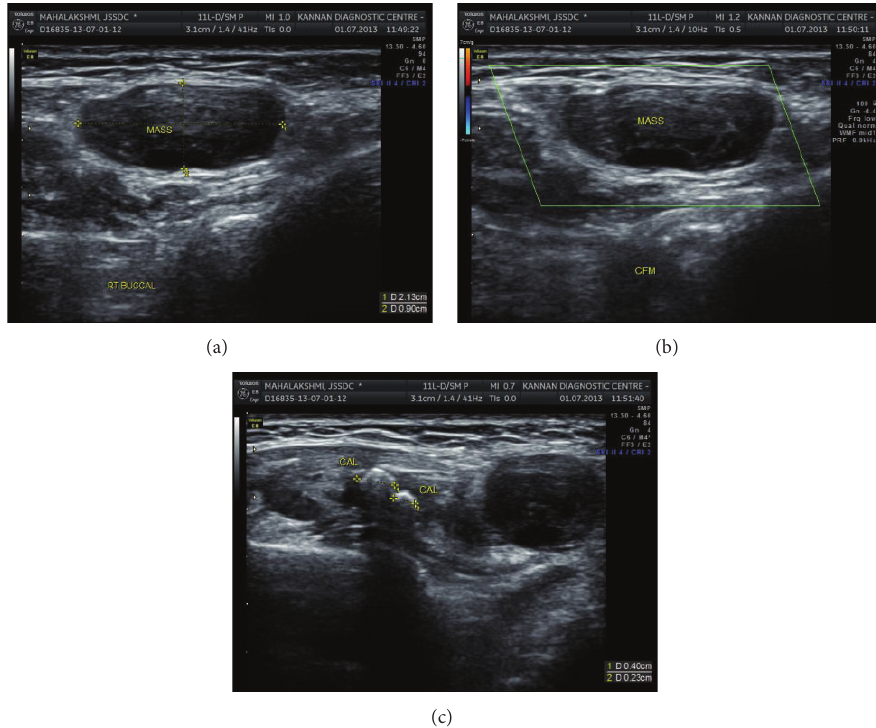
Figure 6: (a) Ultrasonography revealed a well-defined cystic mass within the masseter muscle. (b) Color doppler sonography indicated the mass to be avascular. (c) Ultrasonographic appearance of the calcific masses.